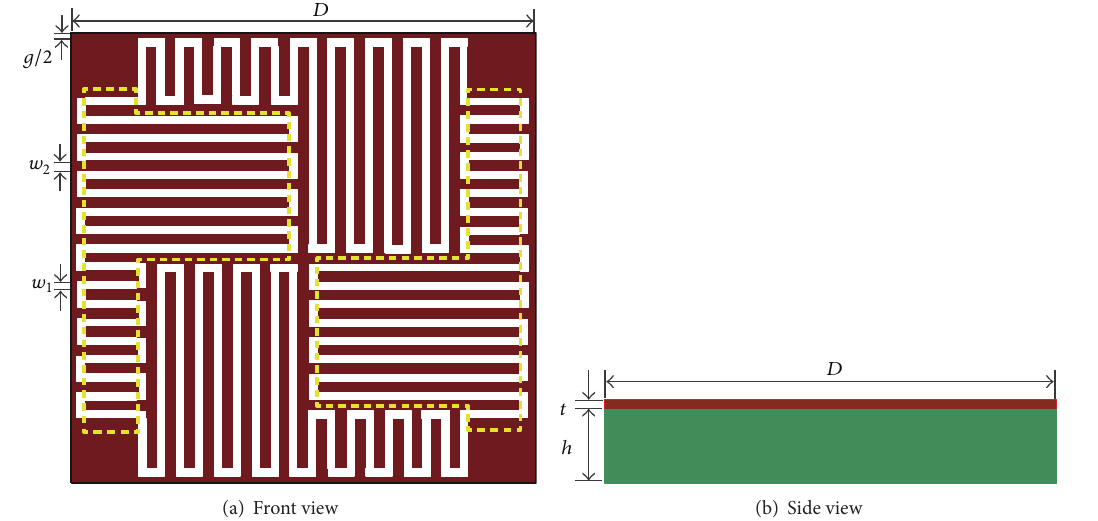
Figure 6: Structure of the proposed FSS element.